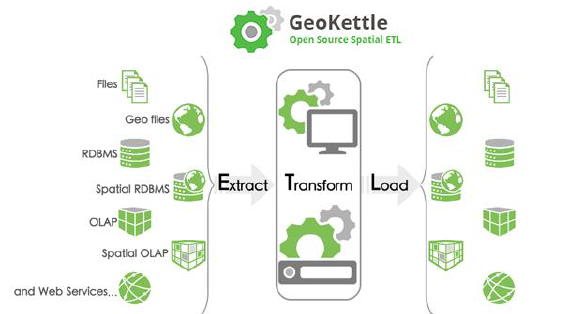
Figure 6. GeoKettle as a metadata-driven spatial ETL tool ( http://www.spatialytics.org/projects/geokettle/ )